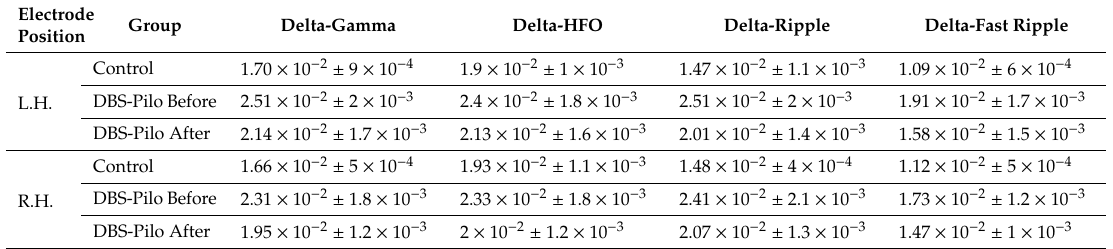
Table 1. Maximum PAC between delta (1–4 Hz) and fast (30–600 Hz) oscillations.